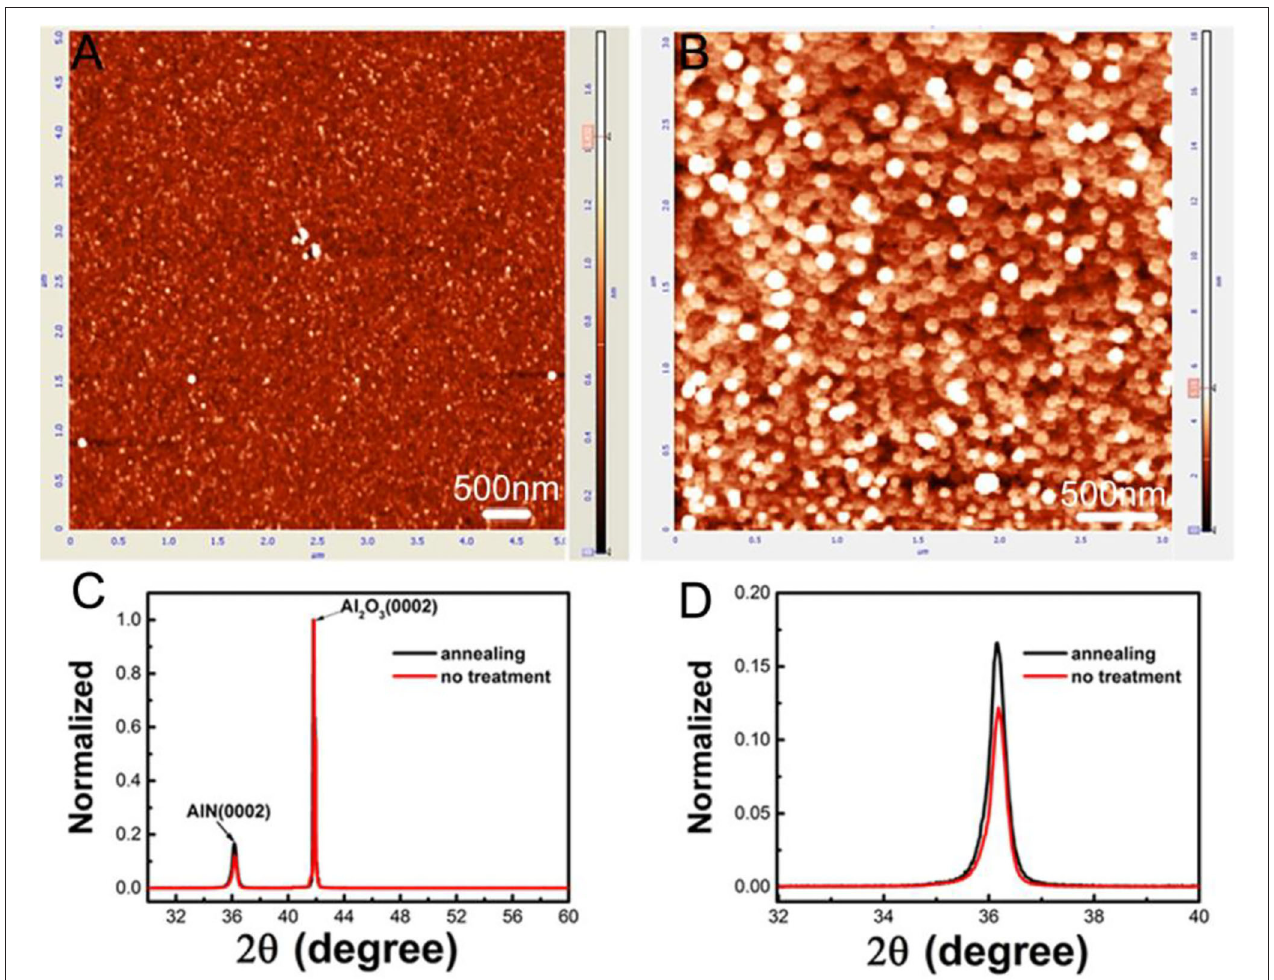
FIGURE 2 | AFM images of LT-AlN without (A) and with (B) annealing treatment. (C) ω -2 θ scan patterns of the (002) plane peak of LT-AlN with and without annealing treatment. (D) Magnification of (C)